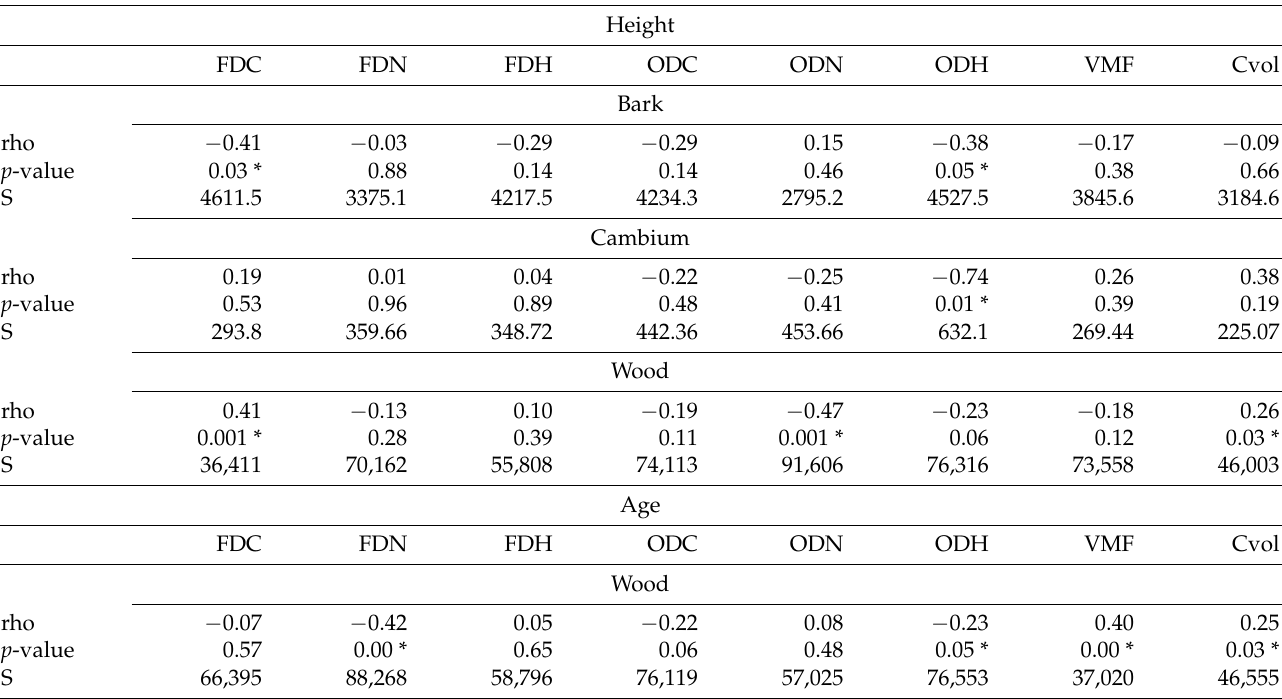
Table 4. Spearman-rank correlation between bark/tissue and tree height and